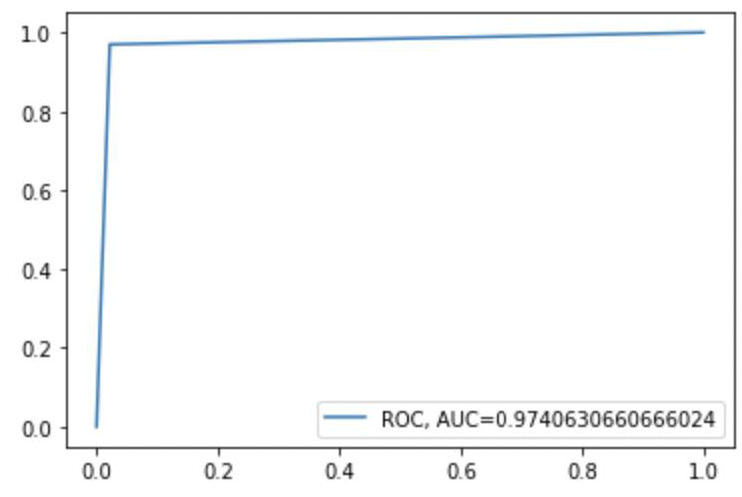
Figure 12. ROC-AUC curve of SVM model.